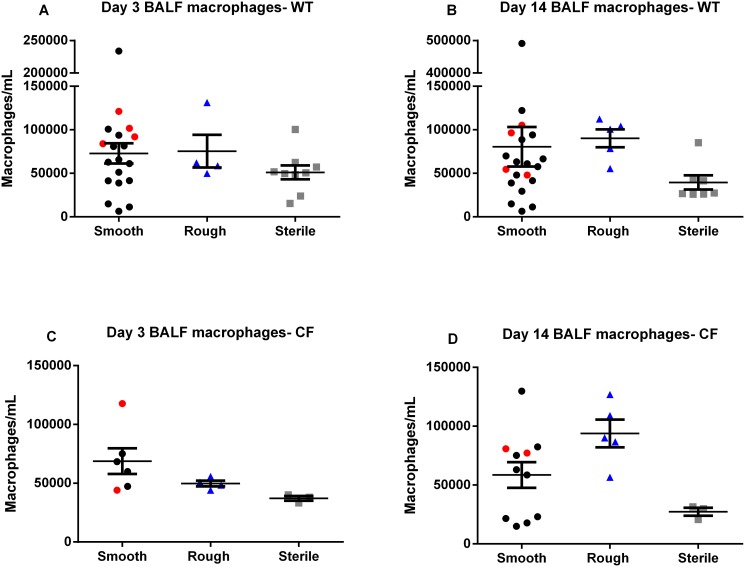
BALF macrophages.(A, B, C and D) Levels of BALF macrophages did not differ between groups. (N = 9–20 mice in each M. abscessus group, N = 3–8 mice in each sterile group). Data displayed as mean ± SEM of group, pooled from 2–3 replicate experiments for each morphotype.